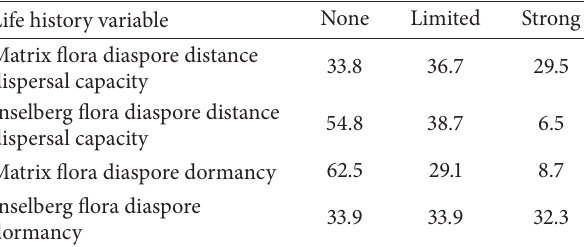
Table 3: Percentage allocation of matrix (guild 0 or 1) and inselberg (guild 5 or 6) floras to dispersal and dormancy categories. Life history variable None Limited Strong Matrix flora diaspore distance dispersal capacity Inselberg flora diaspore